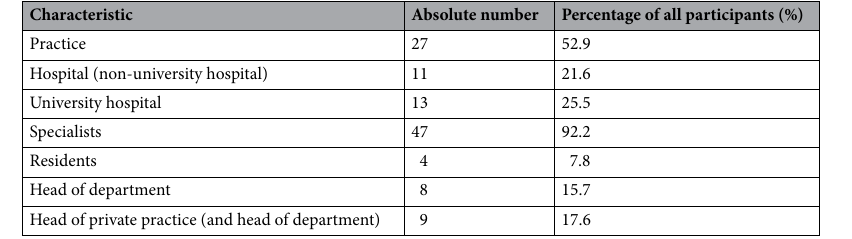
Table 2. Participant characteristics.